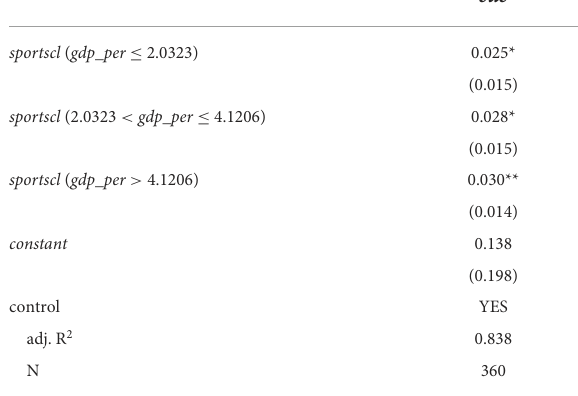
TABLE 7 Threshold regression